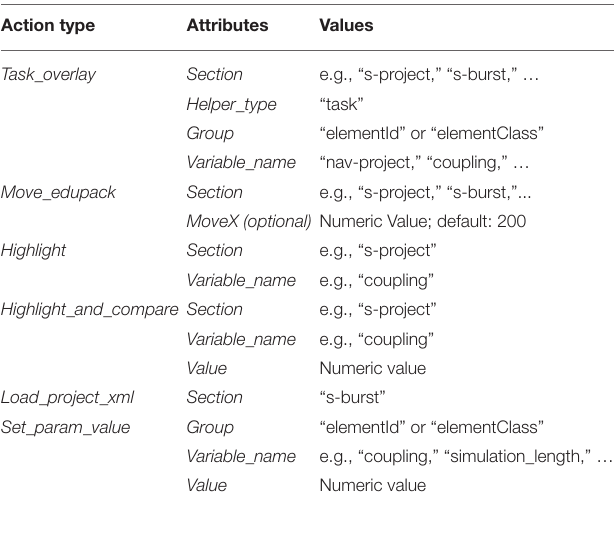
TABLE 1 | Action types and corresponding attributes and